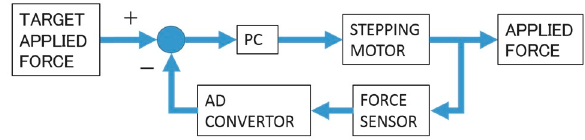
Figure 6. Control block diagram of sensor